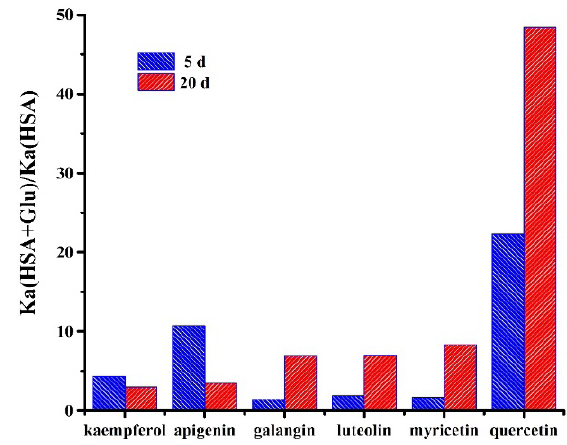
Figure 5: The effect of HSA glycation on the improvement of affinities for